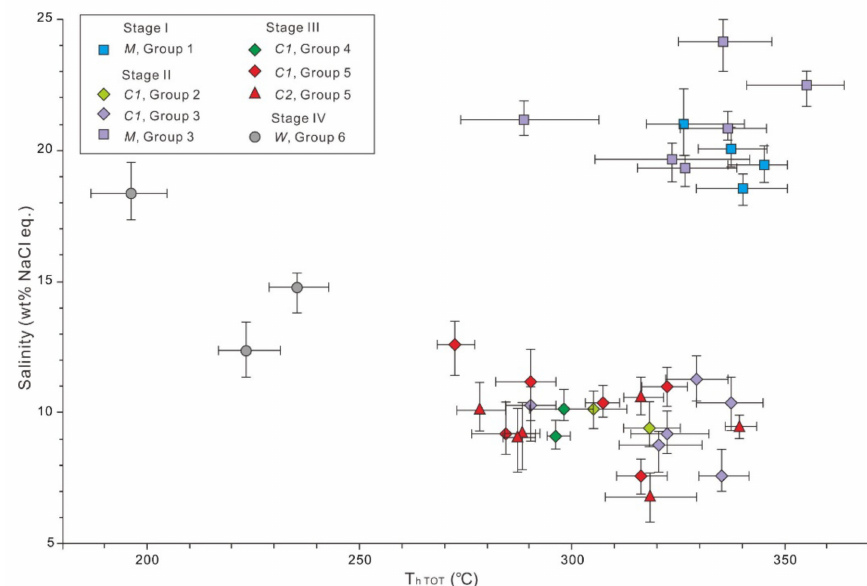
Figure 8. Homogenization temperature ( T h TOT ) versus salinity (wt% NaCl eq.) diagram showing the evolution of the ore-forming fluids for different groups of FIA from stages II and III quartz in the Sanakham gold deposit. The horizontal and vertical bars are the ranges of T h TOT and salinity of every single